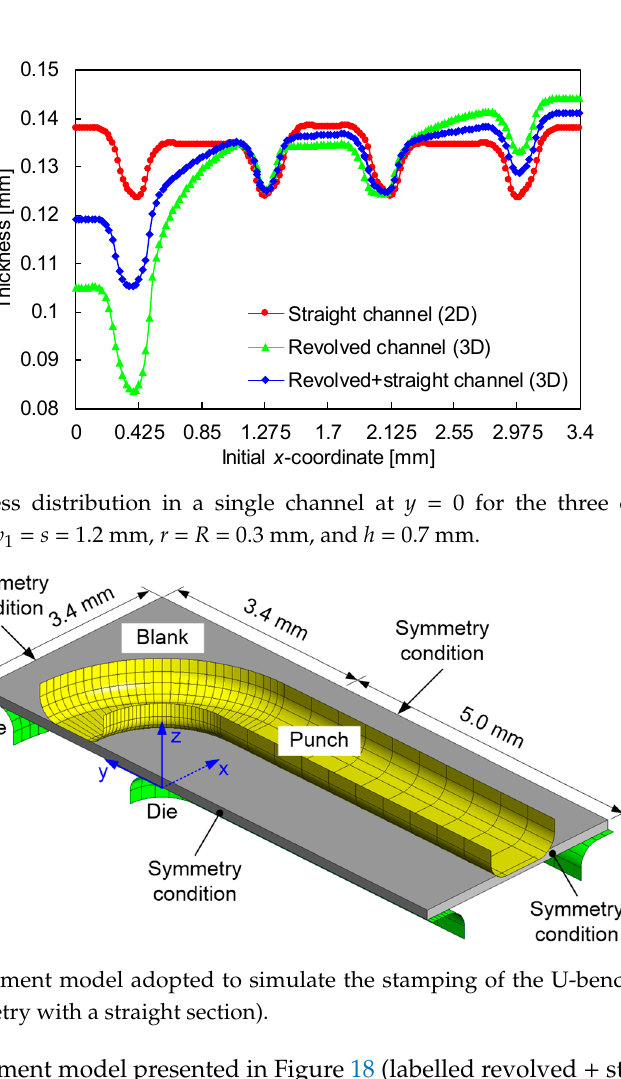
Figure 18. Finite element model adopted to simulate the stamping of the U-bend channel section (revolved tool geometry with a straight section).